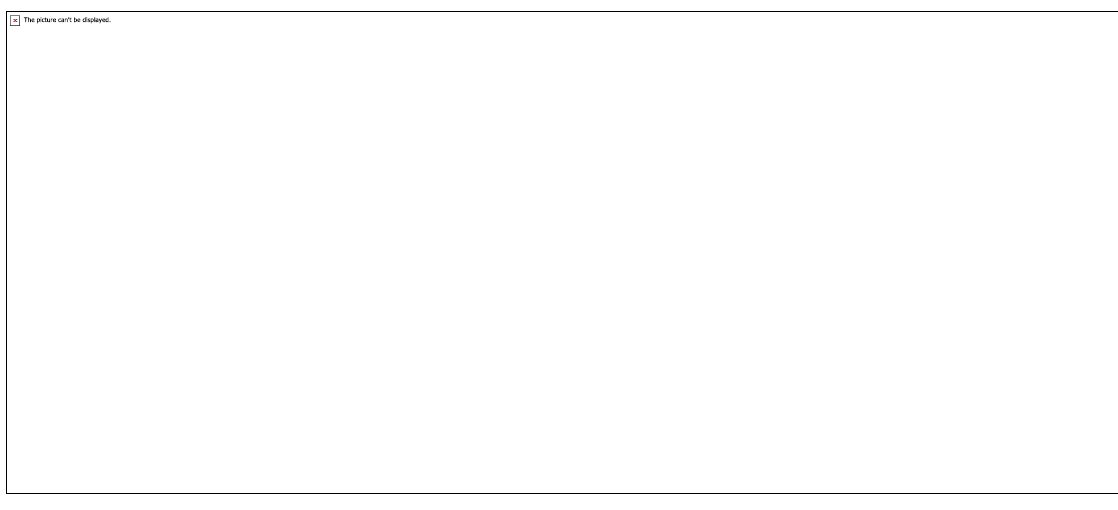
Figure 3: Water Pipelines Plan and